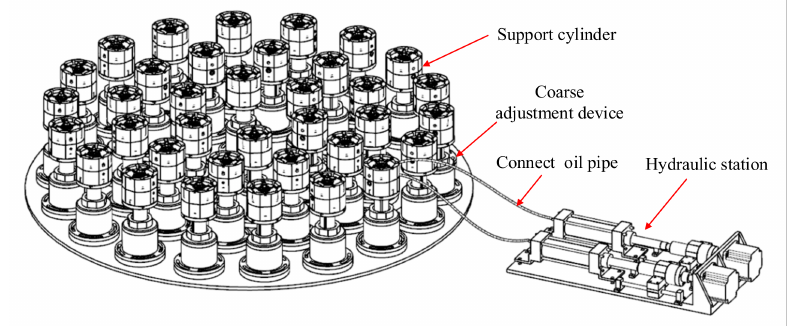
Figure 1. Topology of the flexible support